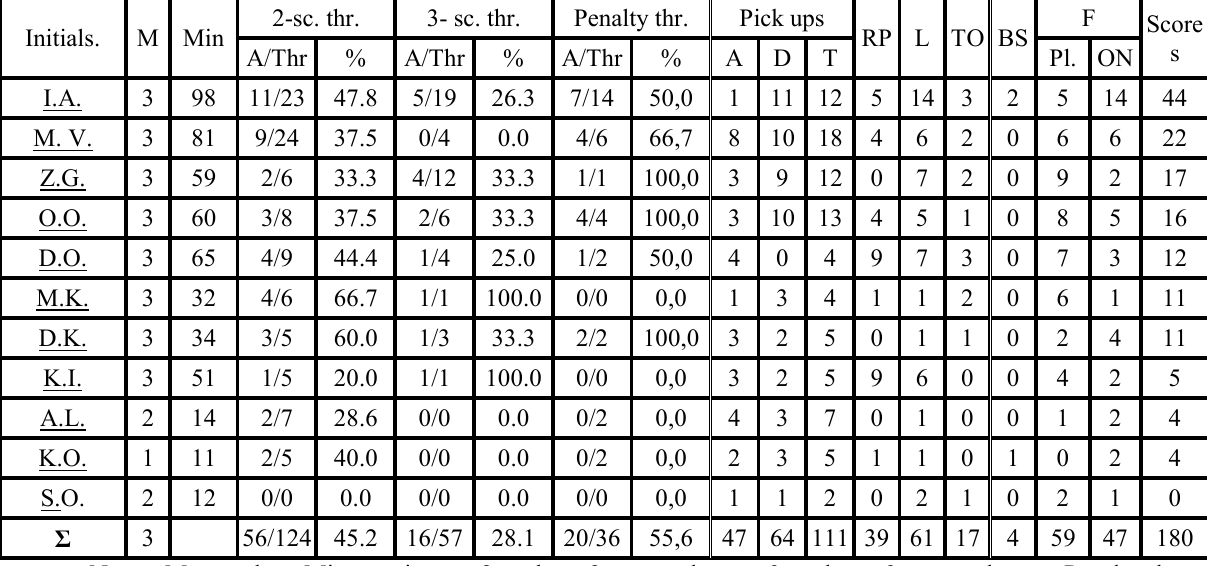
table 4. Quantitative analysis of game time of national Ukrainian combined team’s female basketball players correspond to indicators of advanced teams of European championship 2013: nine sportswomen endured main load for 30 minutes and more. Analysis of game time of national Ukrainian combined team was carried out on the base of three matches, because in further matches Ukrainian combined team did not participate as per sport principle. Combined team of Ukraine lost three games of group tournament and did not enter the next stage of competitions: combined team of Ukraine – combined team of Turkey – 52-78; combined team of Ukraine – combined team of Slovakia – 68-75; combined team of Ukraine – combined team of Montenegro – 60-72. Indicators of technical-tactic actions of female basketball players of combined team of Ukraine at final tournaments of European championship 2013